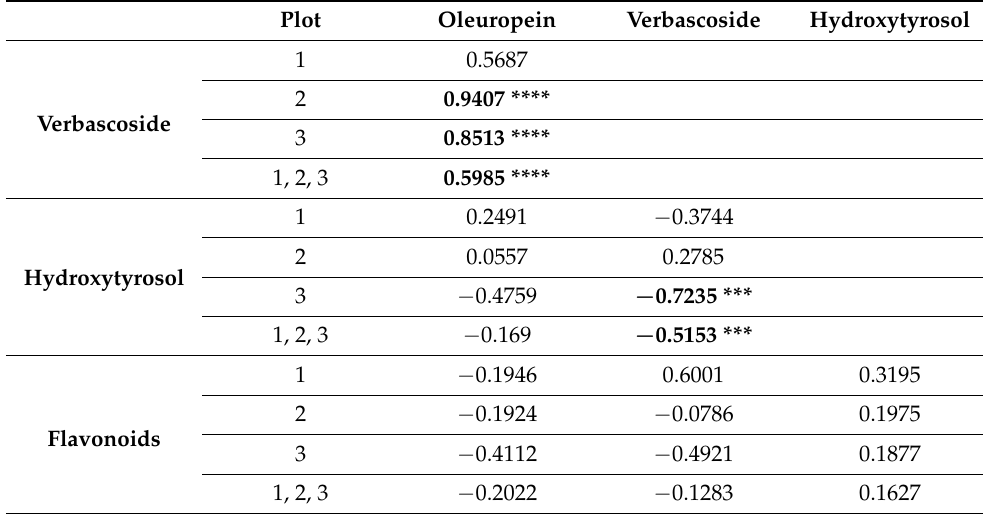
Table 3. Correlation between studied phenolic compounds of olive leaves.